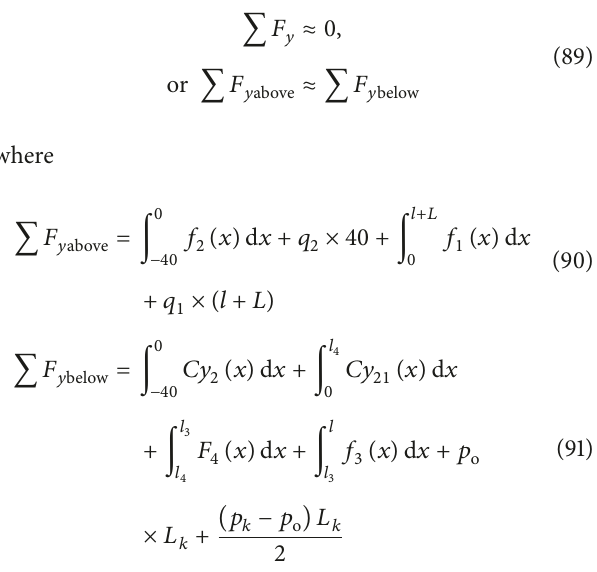
seam system in the rear of 𝑥 = −40 m cross-section in Figure 4, the relationship between the vertical loads along the